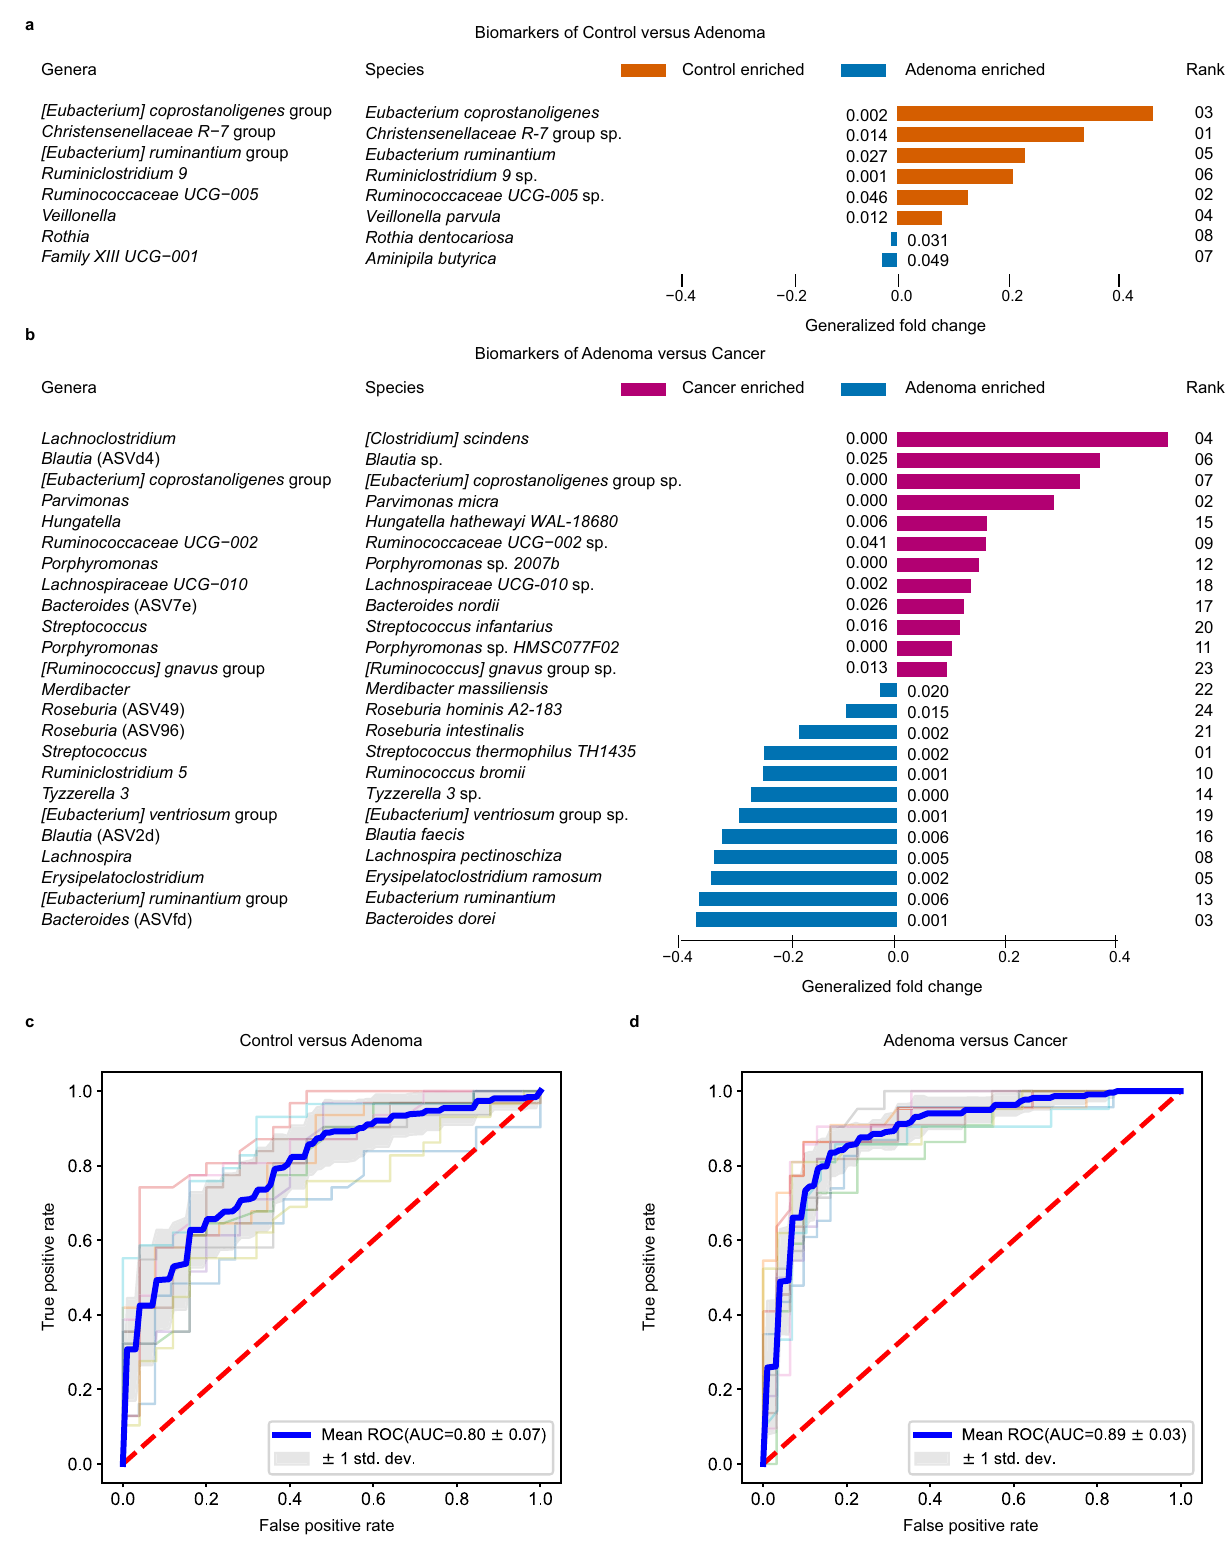
Fig. 2 Performance of discriminating adenoma from control or cancer using important features. a , b , The biomarkers were identi fi ed to construct RF models for discriminating adenoma from control ( a ) and CRC ( b ). Each biomarker represented a single ASV, and the genera and species columns displayed the taxonomy information for the ASVs at the genus and species level. The rank in a and b indicates the order of feature importance in the RF model; P values were computed using a two-sided blocked Wilcoxon rank-sum test and the exact P values were presented beside the barplots. Generalized fold change (see Methods meta-analysis of differentially abundant ASVs) was indicated by color gradients. Source data are provided as a Source Data fi le. c , d The AUC of the optimized models constructed with biomarkers and patient metadata of control versus adenoma ( c ) and adenoma versus cancer ( d ). Mean AUC and standard deviation of strati fi ed 10-fold cross-validation were shown in c and d